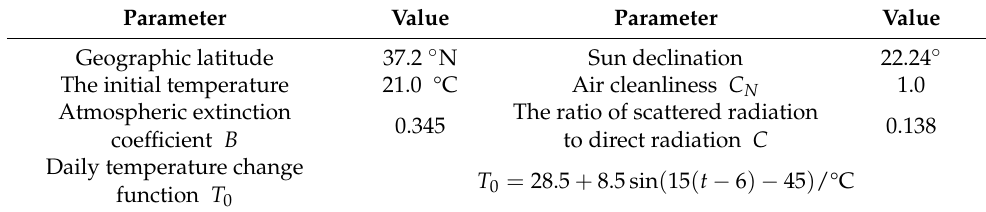
Table 5. Numerical simulation parameters of temperature field.